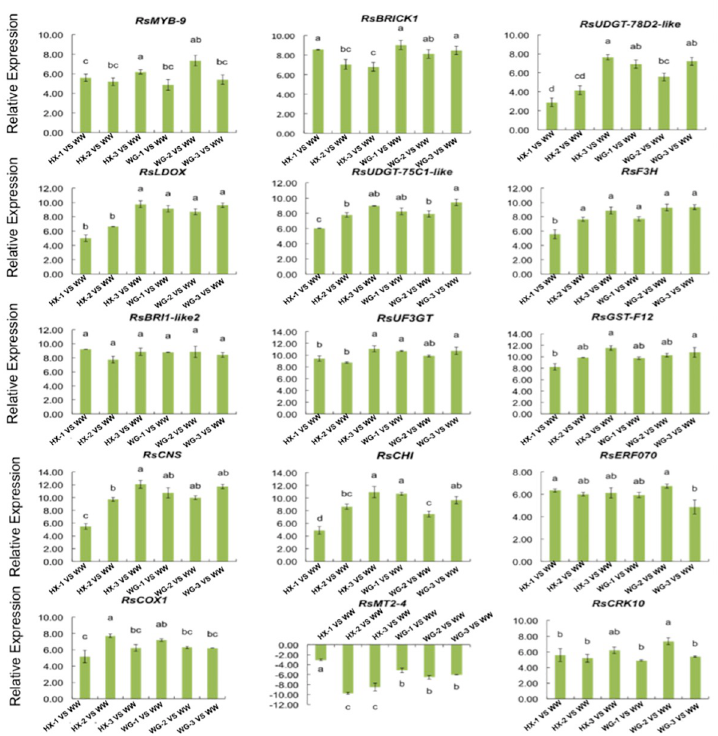
Fig 4. Transcriptional analysis of anthocyanin synthesis-related genes (ASRGs) identified in six cultivars of radish (‘HX-1’,’HX-2’,’HX-3’,’WG-1’,’WG-2’ and ‘WG-3’) using qRT-PCR, compared to WW_NM radish. Relative gene expression levels were normalized against actin transcript levels, and fold change of gene expression of six cultivars of radish comprising of ‘HX-1’, ‘HX-2’, ‘HX-3’, ‘WG-1’, ‘WG-2’ and ‘WG-3 ‘ was identified by comparing each cultivar with ‘WW_NM’, such as ‘HX-1’ vs. ‘WW’, ‘HX-2’ vs. ‘WW’, ‘HX-3’ vs. ‘WW’, ‘WG-1’ vs. ‘WW’, ‘WG-2’ vs. ‘WW’, and ‘WG-3’ vs. ‘WW’. The standard error calculated from three biological replicates and significant (P < 0.05) difference identified by uncorrected Fisher’s LSD test in multiple comparisons after two-way ANOVA are indicated by error bars and stars, respectively. Values connected by the same letter within the same gene and data collection point are not significantly different at P �